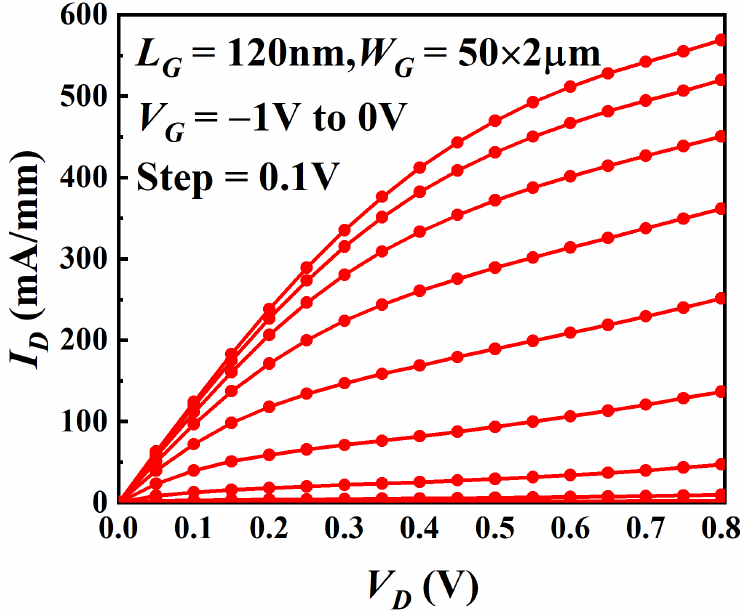
Figure 5. Output characteristics of the InGaAs HEMTs on Si